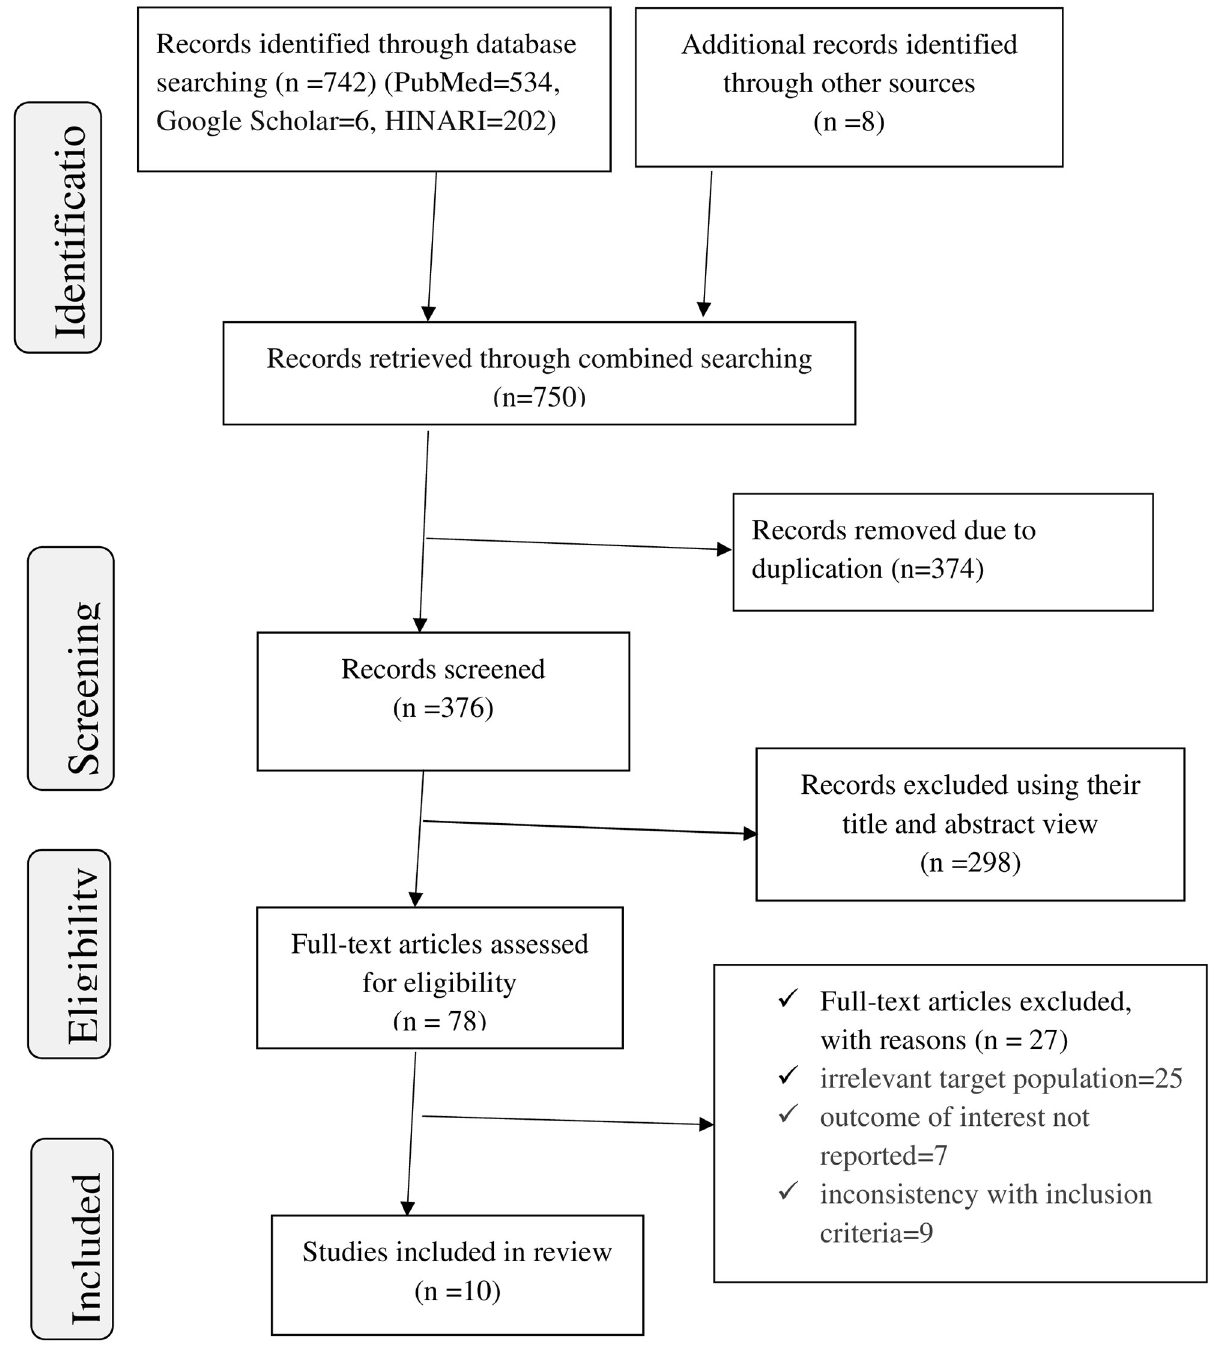
Fig 1. PRISMA flow chart revealing study selection for systematic review and meta-analysis of the practice of active management of the third stage of labor in Ethiopia.